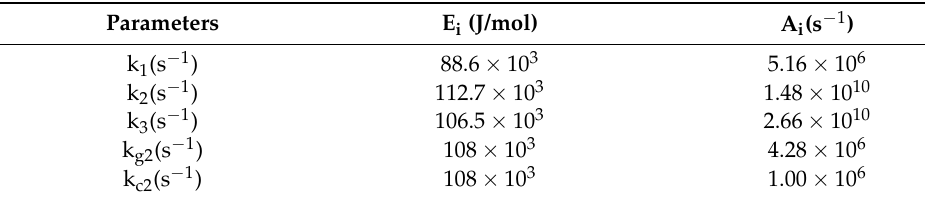
Table 1. Constants used